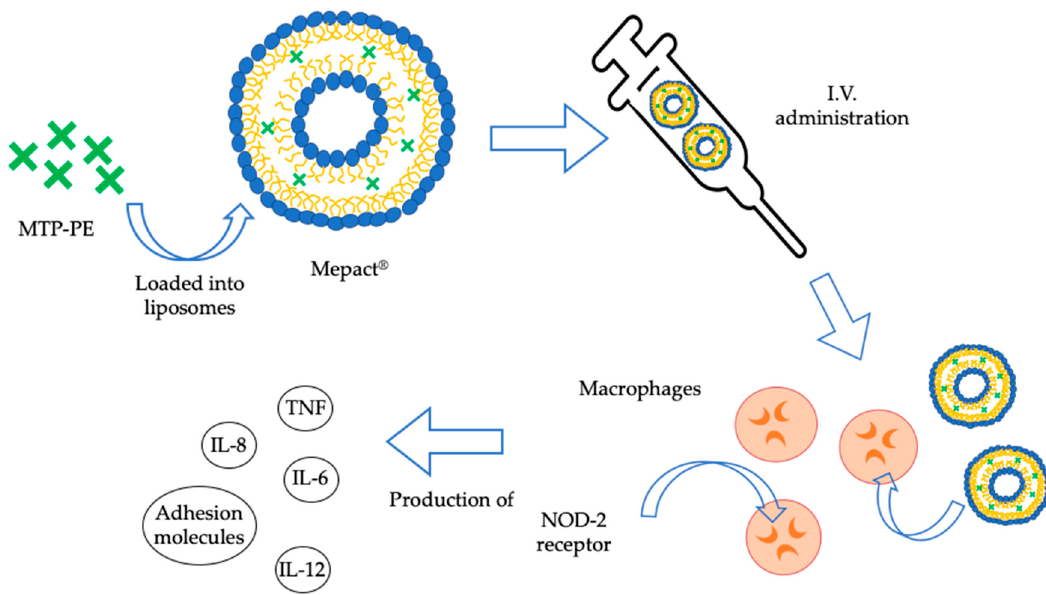
Figure 2. Mechanism of action of liposomal muramyl tripeptide phosphatidyl ethanolamine (MTP-PE). It is a specific ligand of NOD2 which is an intracellular receptor in monocytes, dendritic cells and macrophages: the activation of these cells produces cytokines e.g., tumor necrosis factor (TNF), several interleukins (IL), e.g., IL-6, IL-8, IL-12 and adhesion molecules without effects on tumorigenic cells.